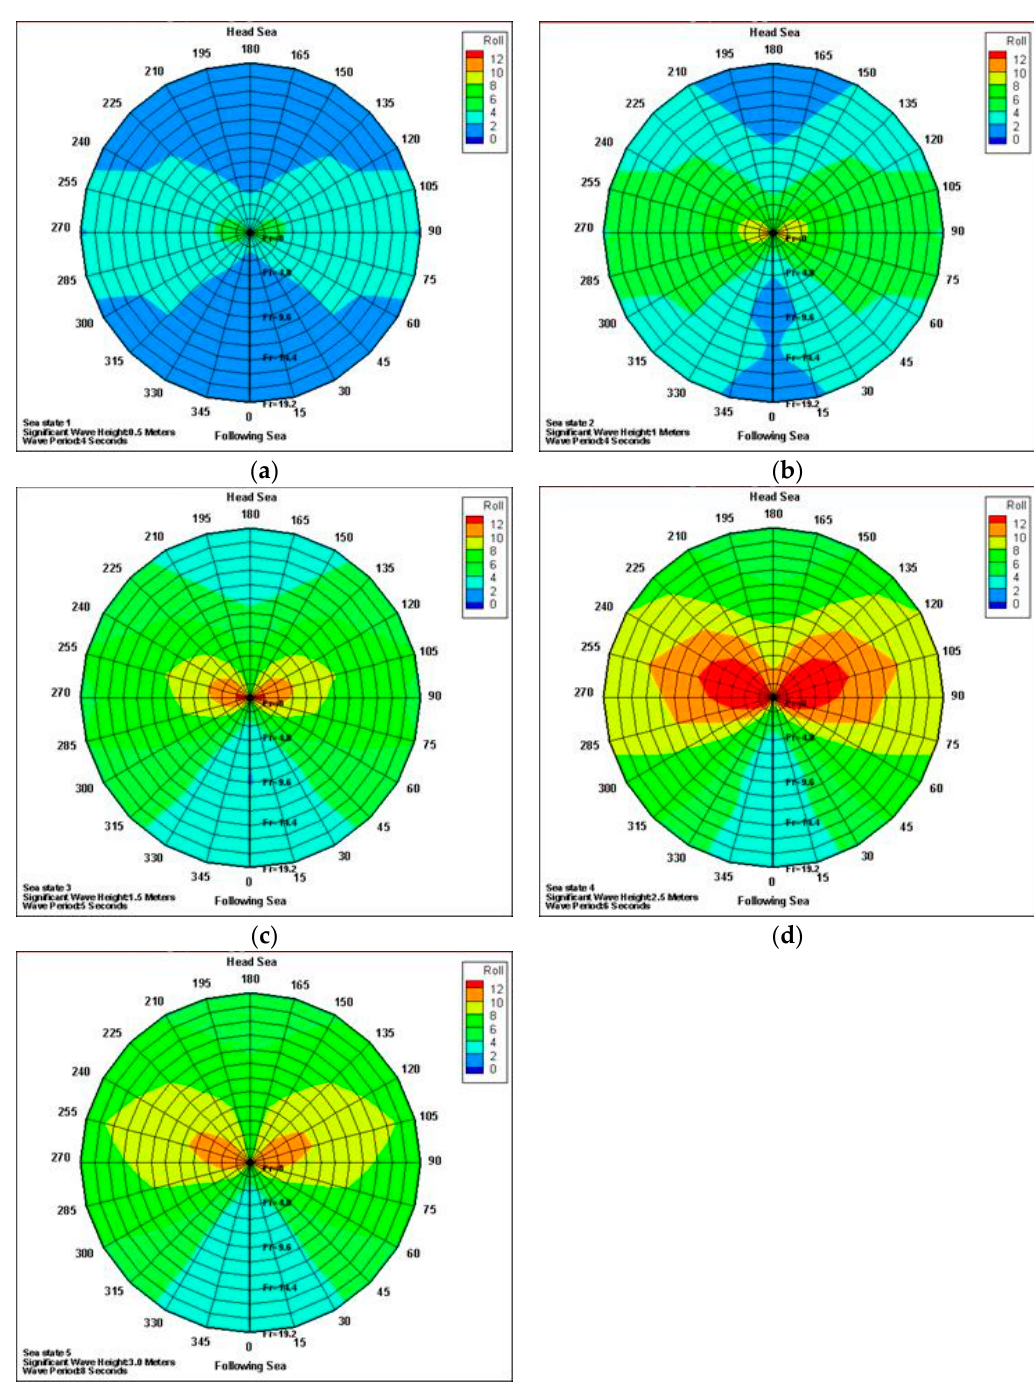
Figure 13. Speed polar diagrams of rolling motion in combination with sailing speeds and wave heading angles under sea states of ( a ) 1, ( b ) 2, ( c ) 3, ( d ) 4, and ( e ) 5, respectively.